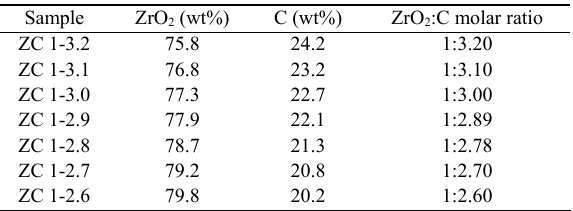
Table 1 Composition of investigated ZrO 2 –C mixtures Sample